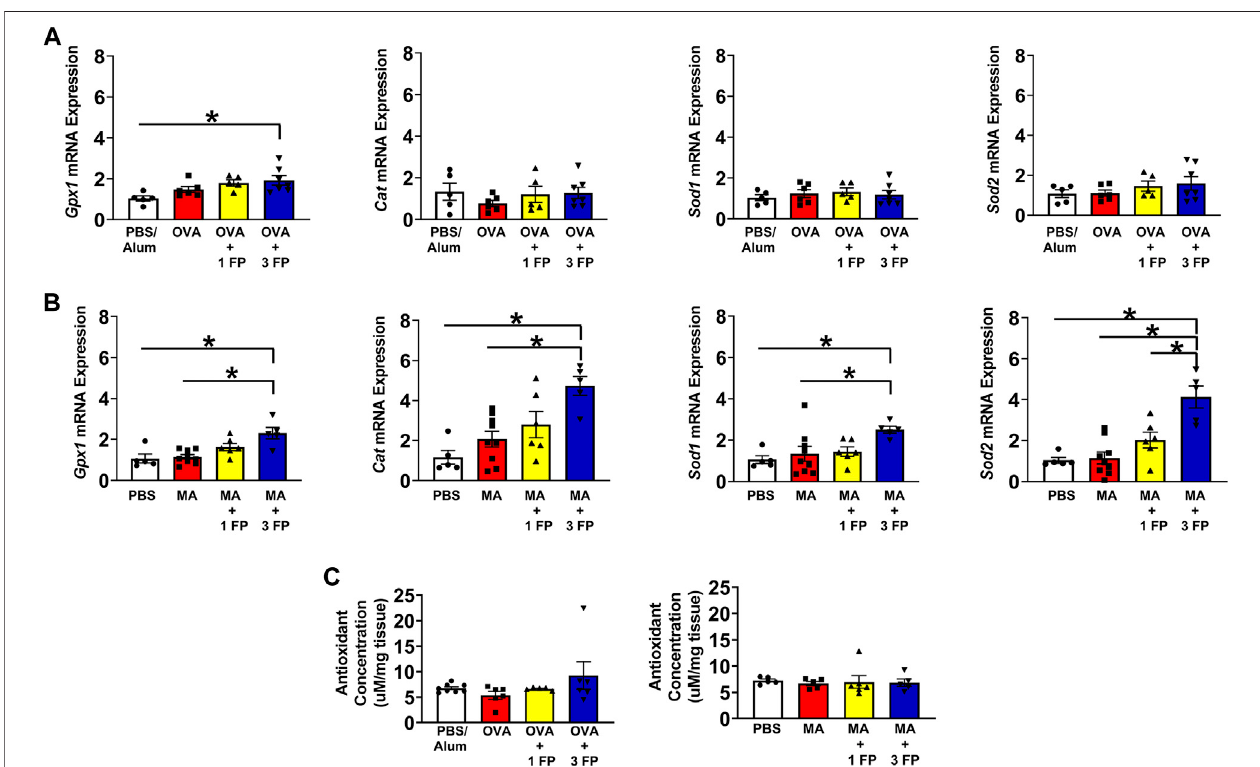
FIGURE 5 | Antioxidant gene expression and total antioxidant capacity. (A) OVA- and (B) MA-challenged mice exhibited no signi fi cant differences in antioxidant gene expression compared to PBS controls. In MA-challenged mice, treatment with 3 mg/kg FP resulted in increased Gxp1, Cat, Sod1, and Sod2 mRNA expression. (C) Total antioxidant capacity remained unchanged in OVA- and MA-challenged mice. Data are presented as ± SEM, n = 5 – 8 mice per group. p < 0.05. * indicates signi fi cant difference between groups.